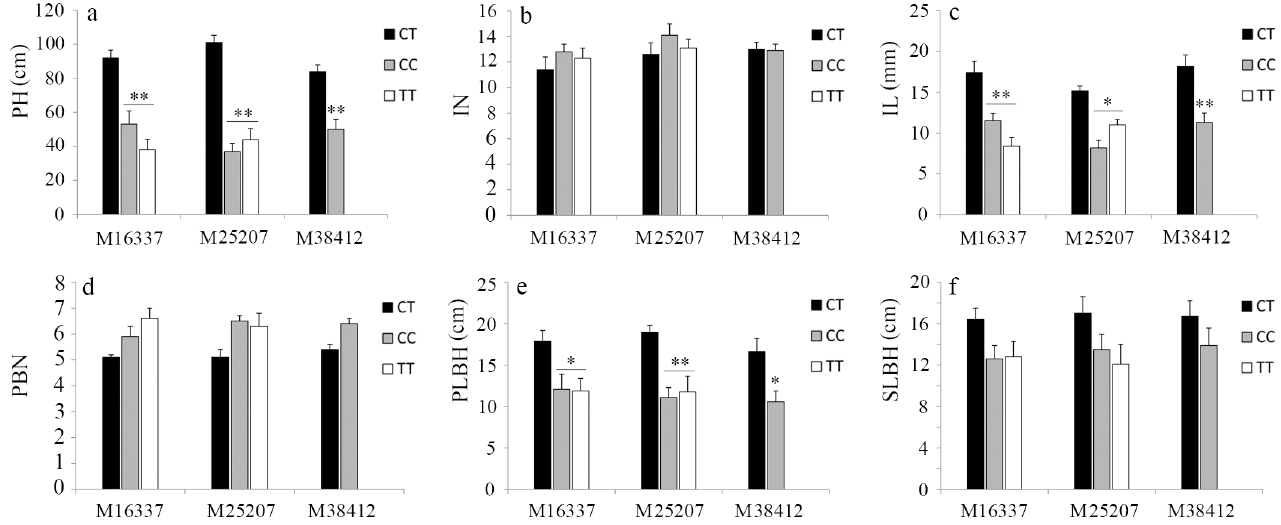
Fig 6. Analysis of the phenotype variance corresponding to the three markers in the F 1 population (one-way ANOVA). All of the abbreviations are the same as above. The X-axis represents the three SLAF markers, and the Y-axis represents the phenotypic traits in the F 1 population. (a) Correlation analysis between PH and the three markers, (b) correlation analysis between the IN and the three markers, (c) correlation analysis between the IL and the three markers, (d) correlation analysis between the PBN and the three markers, (e) correlation analysis between the PLBH and the three markers, (f) correlation analysis between the SLBH and the three markers. Pillar colors represent the different genotypes of each marker as follows: black pillar, CT; grey pillar, CC; and white pillar, TT. Asterisks indicate P < 0.05 ( * ) and P < 0.01 ( ** ) according to Student ’ s t